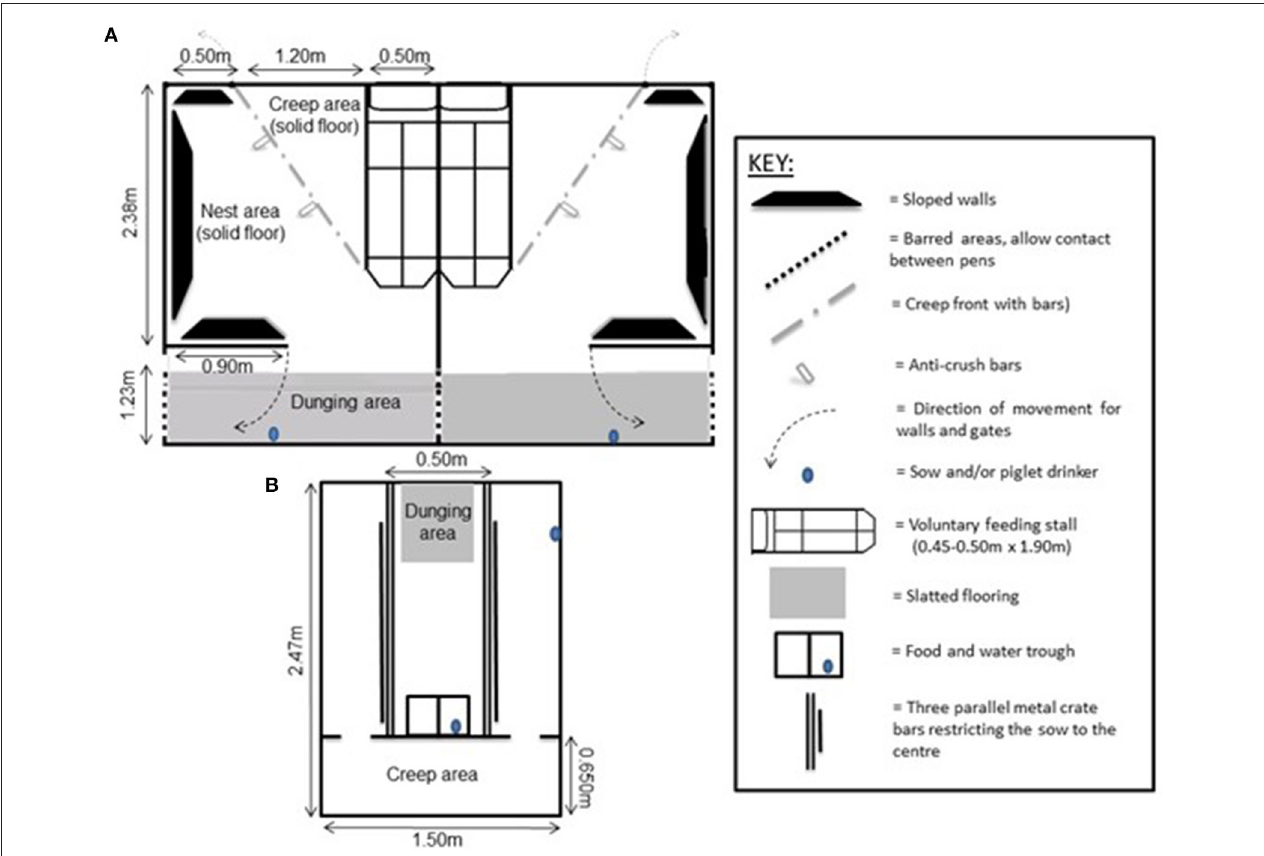
FIGURE 1 | Schematic diagrams (not to scale) of (A) two side-by-side PigSAFE pens (Pens), and (B) a conventional farrowing crate (Crate) used to house farrowing and lactating sows in this study (adapted from: Baxter et al., 2015).